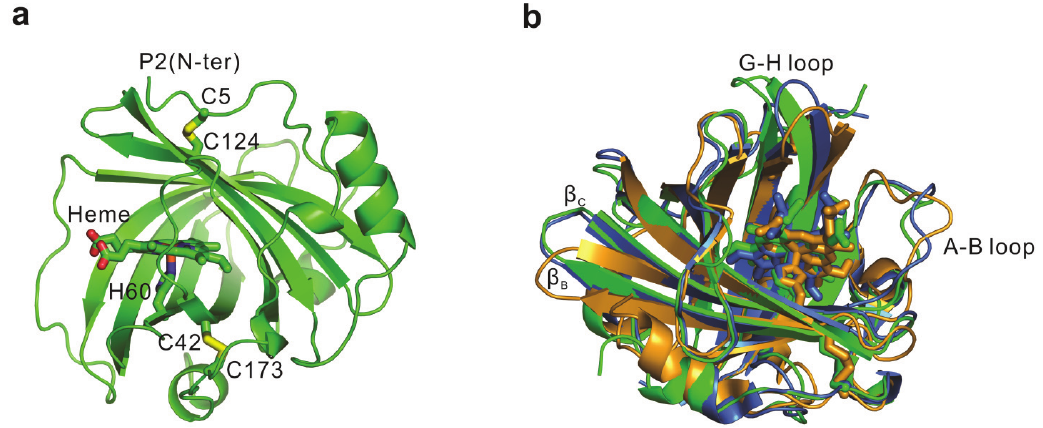
Figure 1. Representation of the backbone structure of X-ray NP7 structures. ( a ) Overall fold of NP7. ( b ) Overall fold of NP7 (green) in comparison to NP2 (blue) (PDB code, 2A3F) and NP4 (orange) (PDB code, 1YWD).